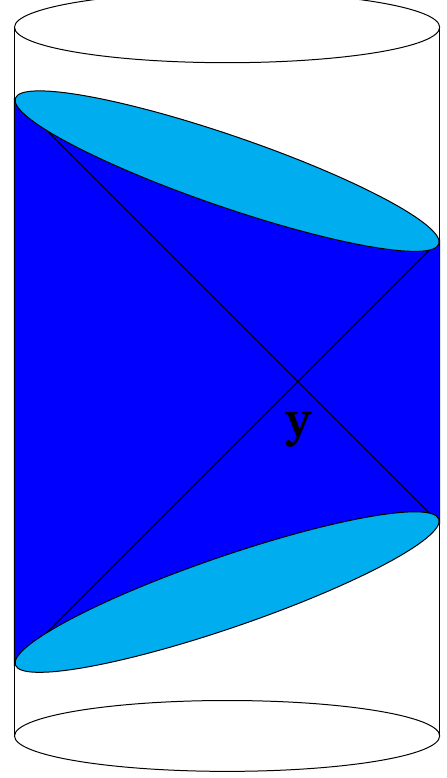
Figure 2: The boundary representation of a bulk scalar field at a point y has support on all boundary points spacelike separated from